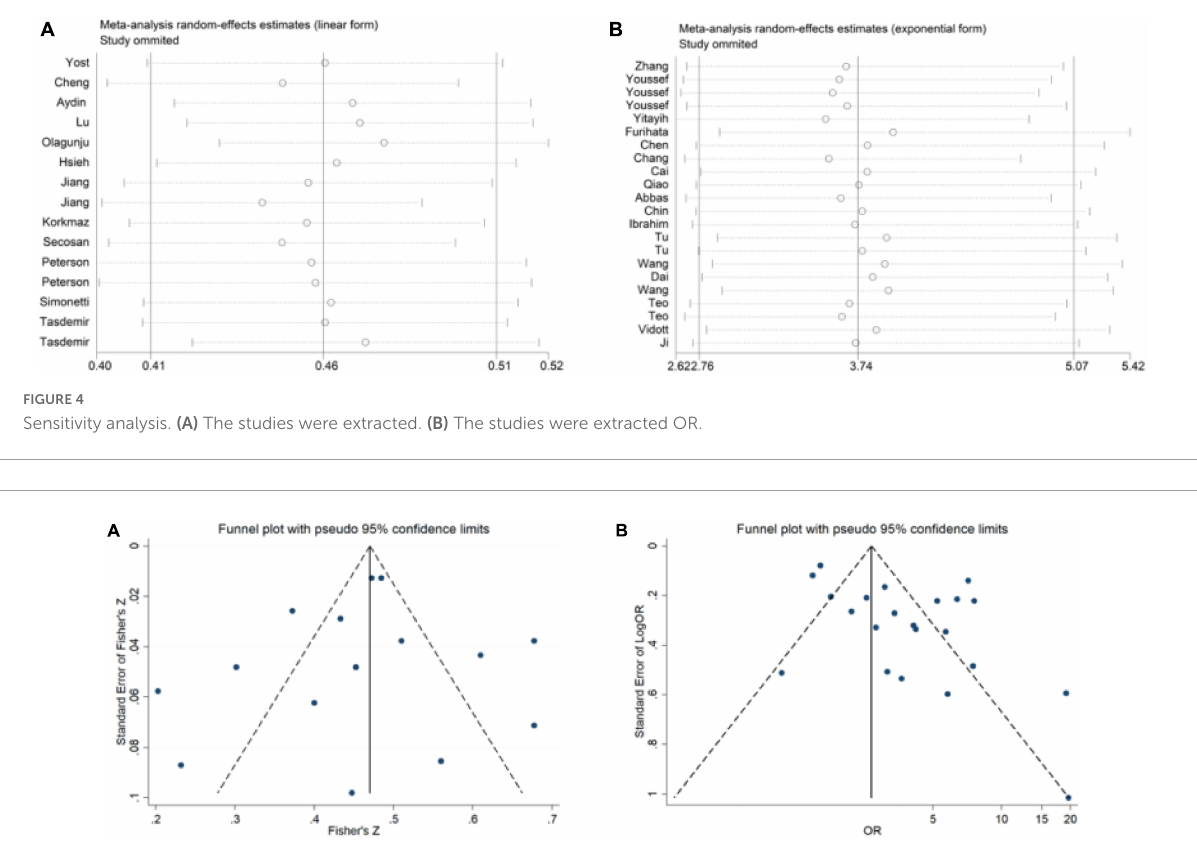
FIGURE5 Publication bias analysis. (A) The studies were extracted. (B) The studies were extracted